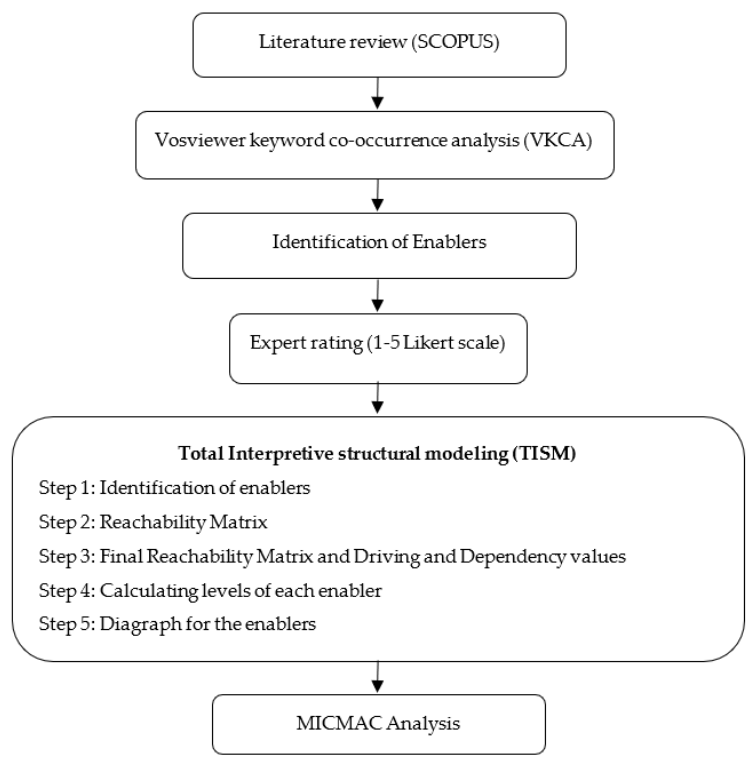
Figure 2. Proposed